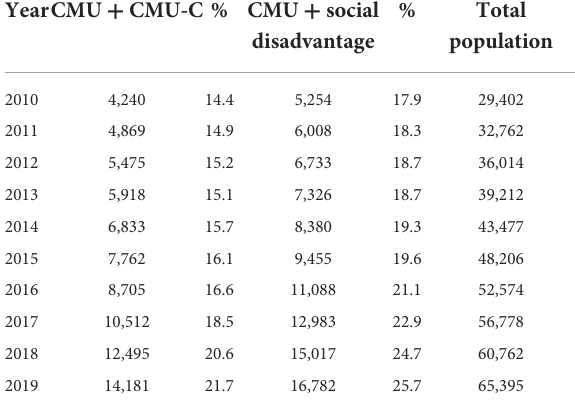
TABLE 9 Levels of social disadvantage among children and adolescents using